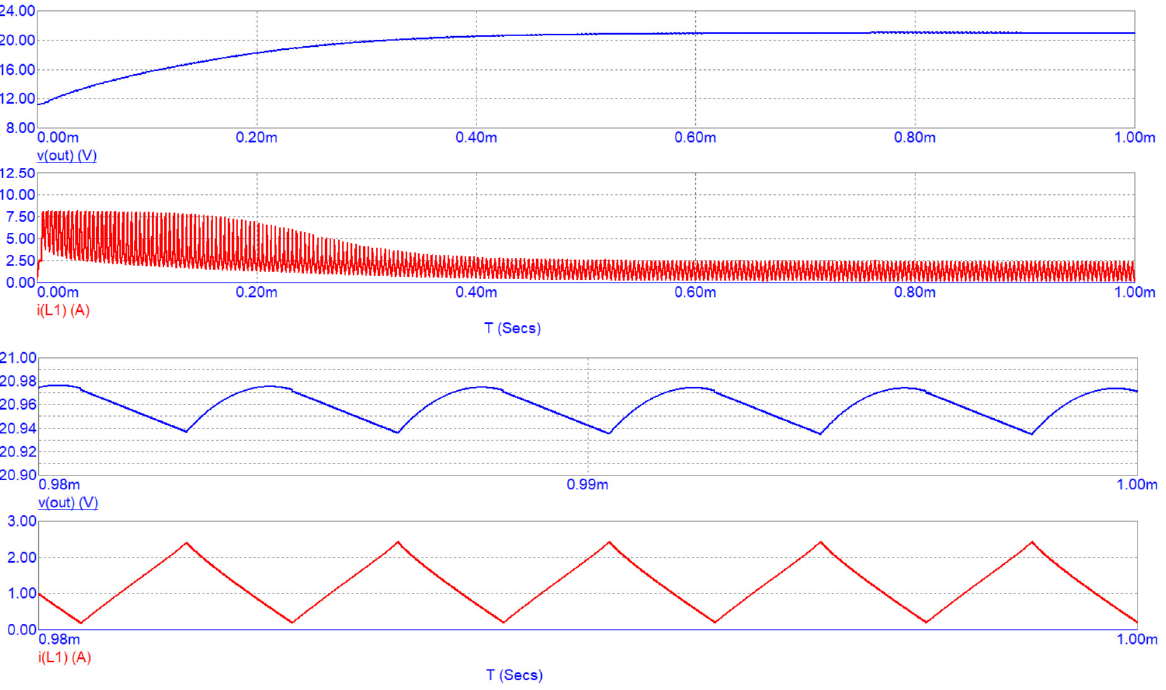
Figure 13. Simulation results of the DC/DC boost converter in Micro-Cap Spice simulator with a non-linear inductor implementing the arctan model. Top figure depicts the output voltage of the converter and the inductor current. Bottom figure depicts a detail of the inductor current and output voltage profiles.